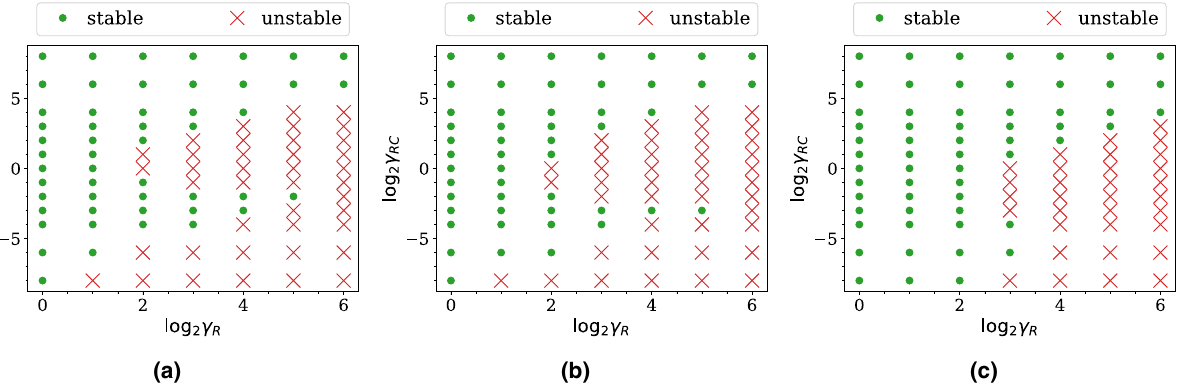
Figure 3. Stability map of the simulations on (a) the coarse grid, (b) the medium grid, and (c) the fine grid of the five-outlet domain. The three maps reveal the same pattern: for log 2 γ RC 3 , a smaller γ RC requires a smaller γ R for log 2 γ RC ≤ −